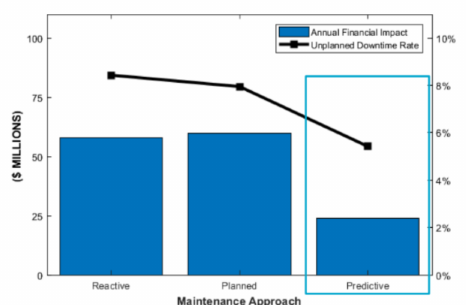
Figure 1. Costs and loss of productivity according to maintenance